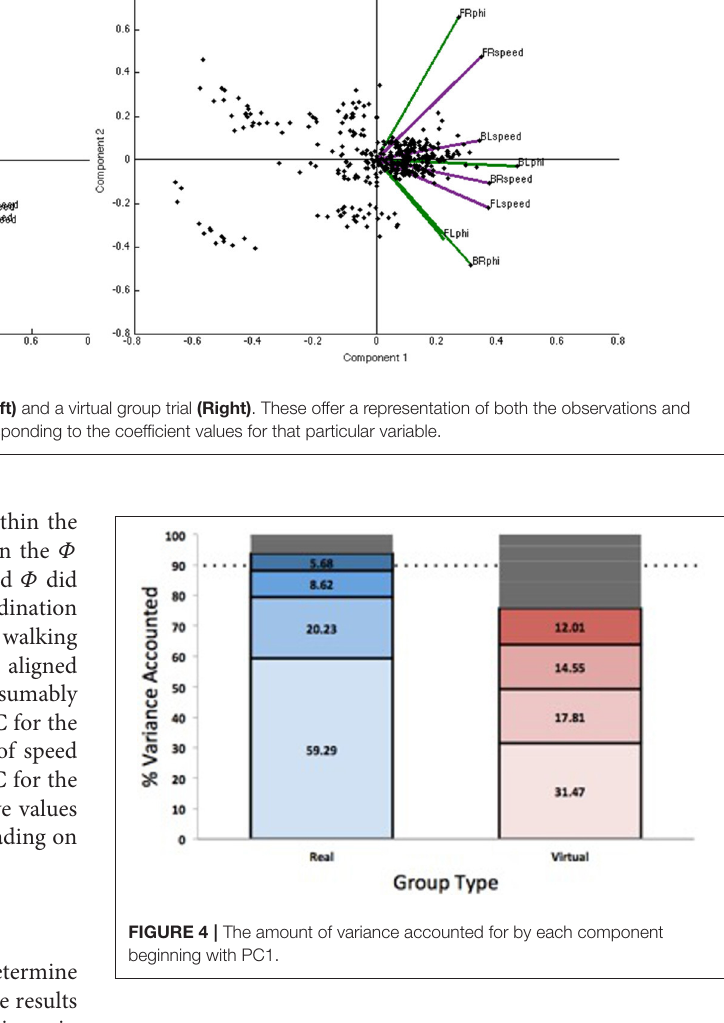
for heading). See Table 1 for skewness, kurtosis, and